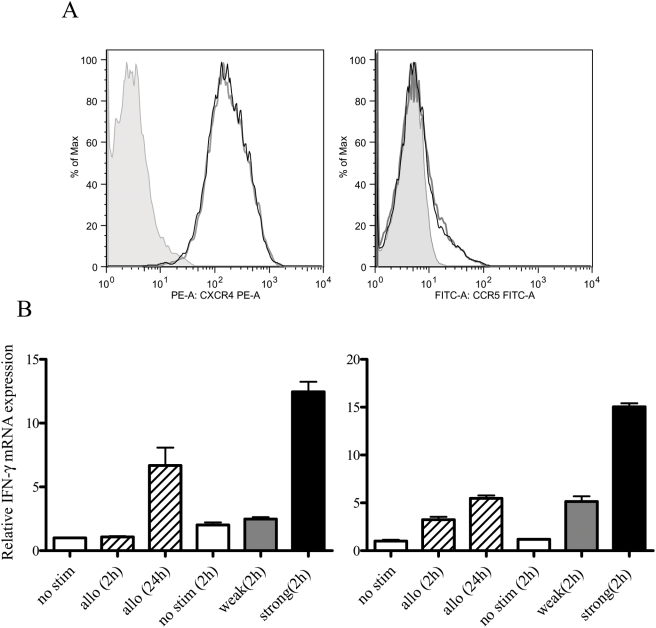
Analysis of CD4+ T cell activation.(A) Primary CD4+ T cells were stimulated with anti-CD3 (5 µg/ml)+anti-CD28 (10 µg/ml) (black bold line), anti-CD3 (0.5 µg/ml)+anti-CD28 (1 µg/ml) (black line), or cocultured with allogeneic CD4+ T cells for 2 h (gray line). Isotype control mAbs were used as a negative staining control (shaded peak). (B) One-step qRT-PCR analysis of IFN-γ mRNA expression in primary CD4+ T cells. Primary CD4+ T cells were cocultured with allogeneic CD4+ T cells for 2 or 24 h and then stimulated with anti-CD3 (5 µg/ml)+anti-CD28 (10 µg/ml) (IL-2 strong), anti-CD3 (0.5 µg/ml)+anti CD28 (1 µg/ml) (IL-2 weak), or no TCR stimulation (IL-2) for 2 h. Total RNA was extracted and analyzed by qRT-PCR. The data was normalized to EF-1α and the relative amount of IFN-γ is shown. The data represents the average ±SD of three independent experiments.